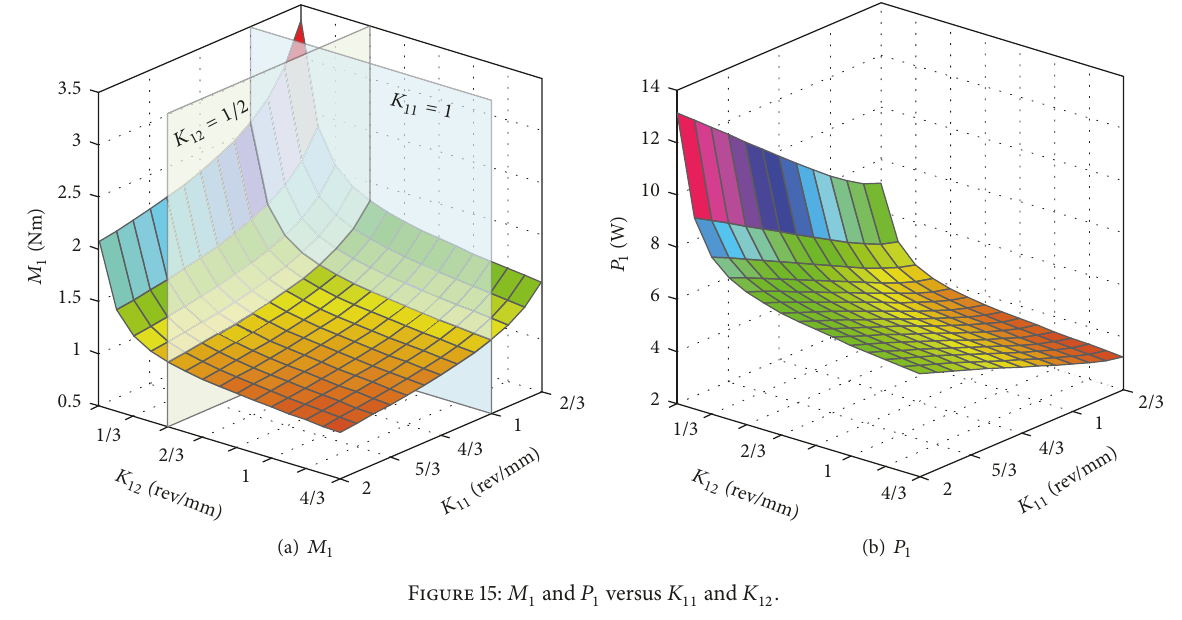
Figure 15: 𝑀 1 and 𝑃 1 versus 𝐾 11 and 𝐾 12 .